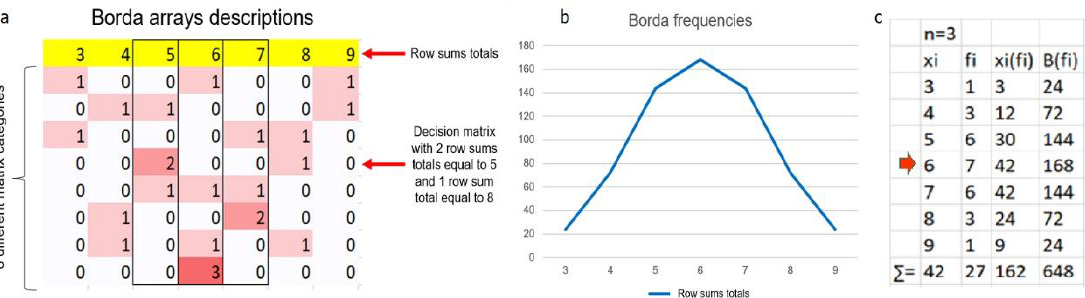
Figure 9. Frequency graph of the row sum totals in Borda aggregation method. ( a ) Borda arrays descriptions, ( b ) Borda frequencies and ( c ) Table of Borda frequencies.